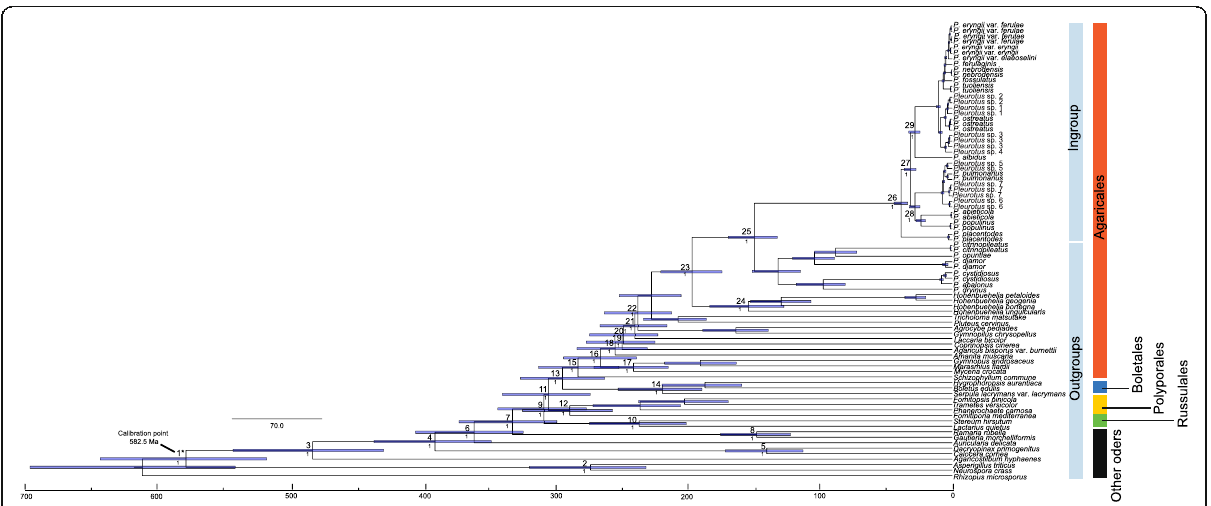
Fig. 2 Maximum clade credible tree of Pleurotus ostreatus species complex based on Dataset IV. The chronogram was obtained using the Ascomycota-Basidiomycota divergence time of 582.5 Ma as the calibration point. Nodes are posterior mean ages (Ma) with blue node bars representing 95% highest posterior density intervals. The calibration point and object of this study are marked in the chronogram. The numbers at nodes indicate the important divergence events. Different orders of fungi included in the BEAST analysis are indicated by different colors used for the species